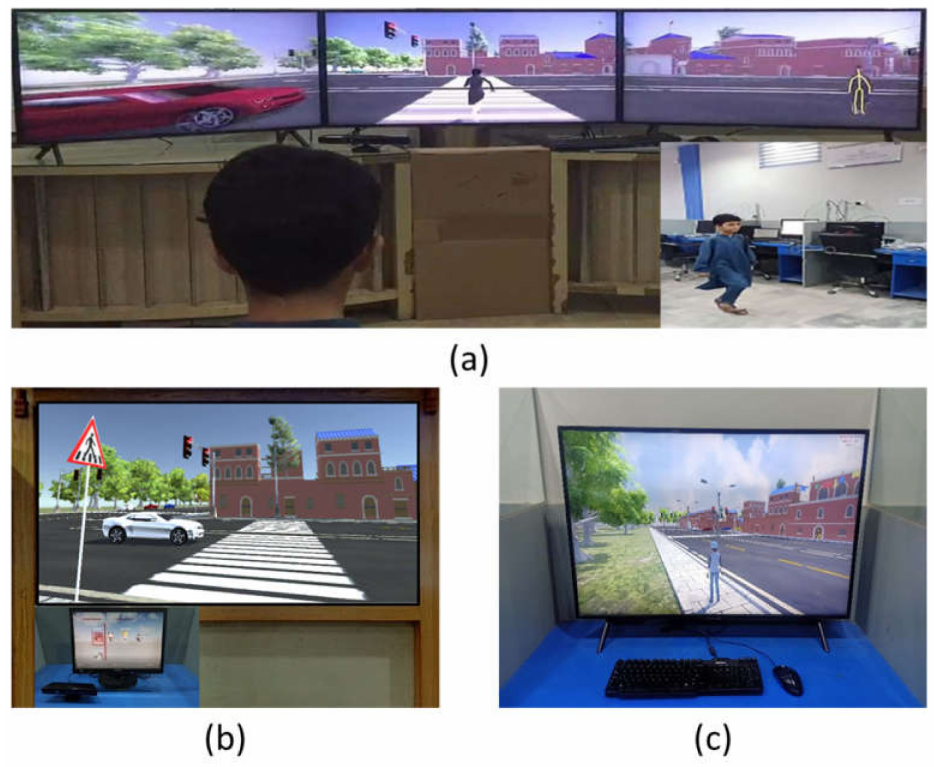
Figure 5. Different display setups of VRBTS where ( a ) shows immersive setup, ( b ) represents living room setup, and ( c ) is a desktop